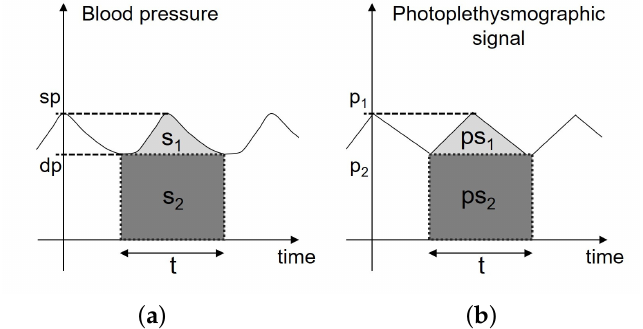
Figure 4. ( a ) Schema of the blood pressure pulsation and time course and ( b ) schema of the photoplethysmographic pulsation and time